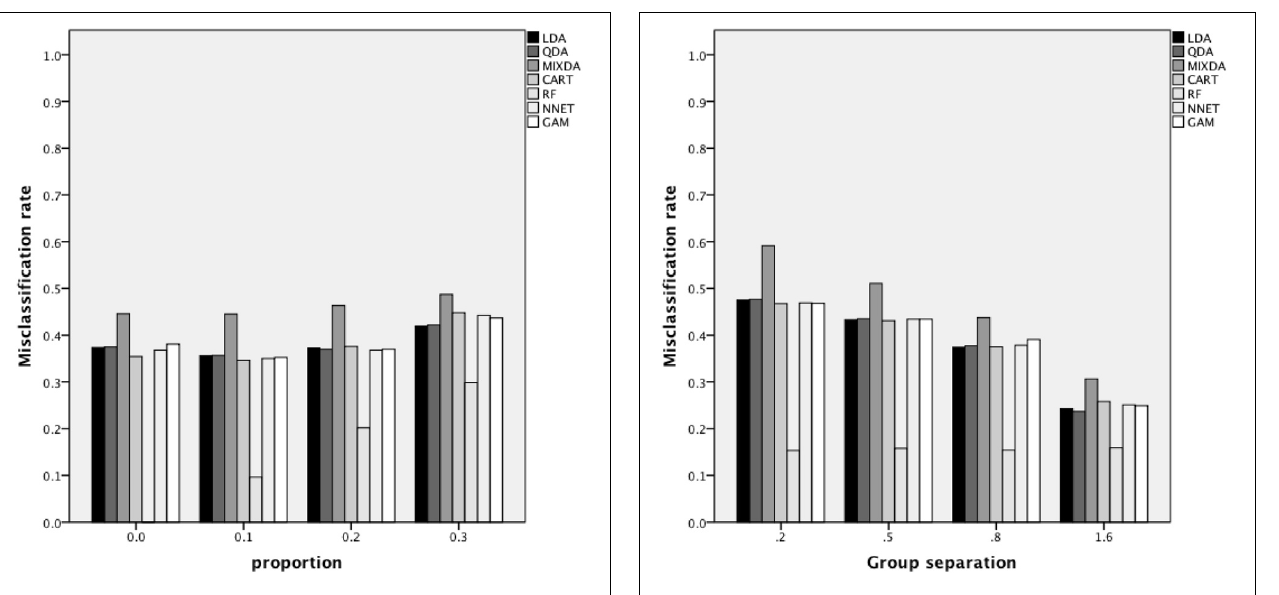
FIGURE 3 | Overall misclassification rate by method and proportion of cases initially misclassified.